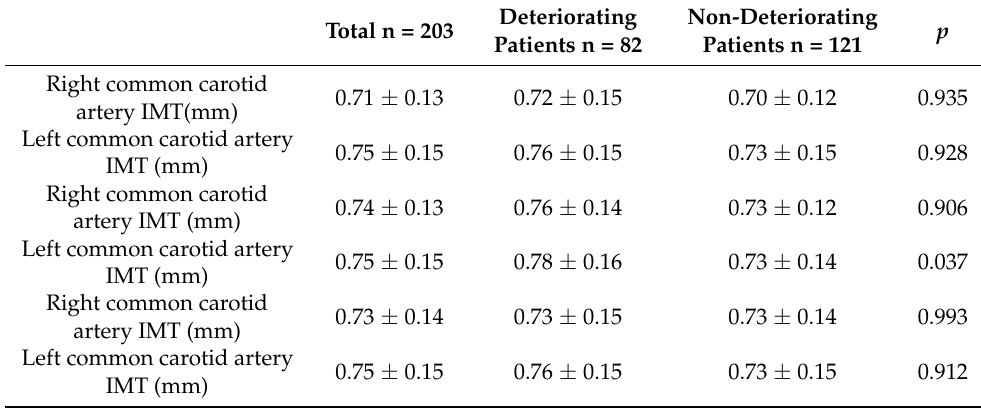
Table 3. Presence of subclinical vascular